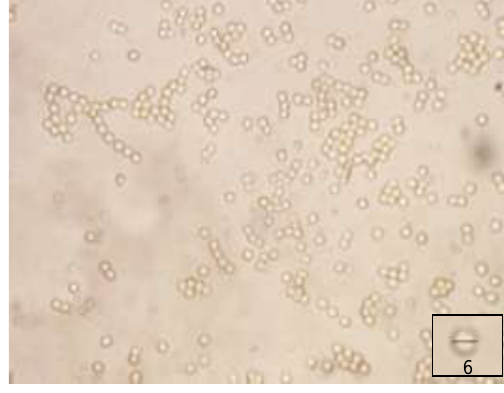
Figure 5: Spores of Branchiomyces spp. stained with Iodine from culture. Bar= 6